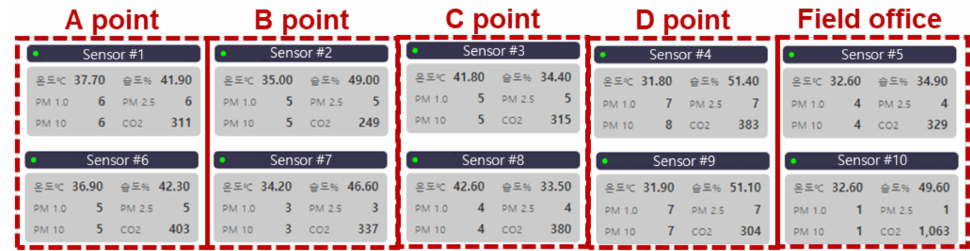
Figure 8. Real-time data services of the program in field